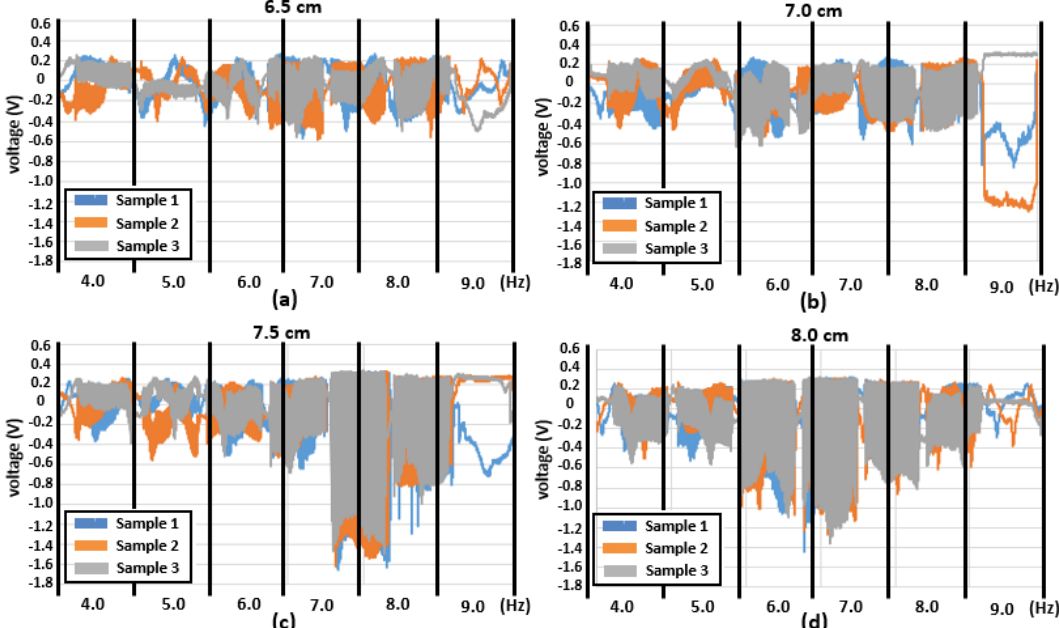
Figure 23. Generated voltage for different cantilever-beam lengths. Three replicas were applied for each test (length and frequency), and 500 measurements were gathered per tested frequency: ( a ) 6.5 cm; ( b ) 7.0 cm; ( c ) 7.5 cm; and ( d ) 8.0 cm.